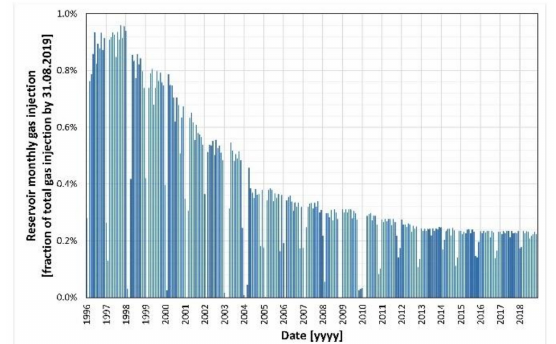
Figure 12. Reservoir monthly gas injection. Fraction of total gas injection by 31.08.2019.